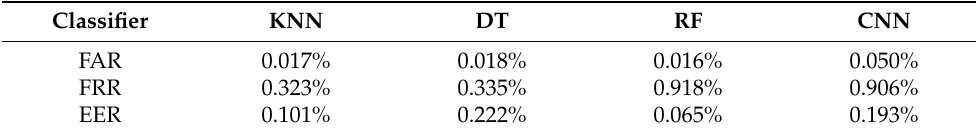
Table 13. AD evaluation—Scenario B (a single point-and-click action): FAR, FRR, and EER.